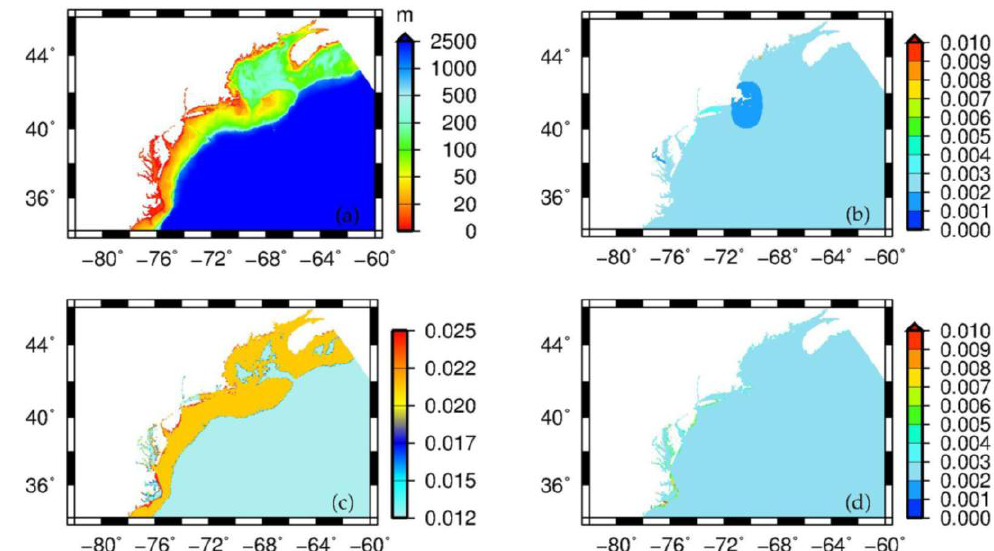
Figure 3. Comparison of bottom friction assignment for the Atlantic coastline from North Carolina to Maine: ( a ) bathymetry—scale from 0 m to 2500 m, ( b ) assigned Vertical Datum (VDatum) friction coefficient ( CF ) values, ( c ) assigned Manning’s n values and ( d ) computed CF values from bathymetry and assigned Manning’s n values.